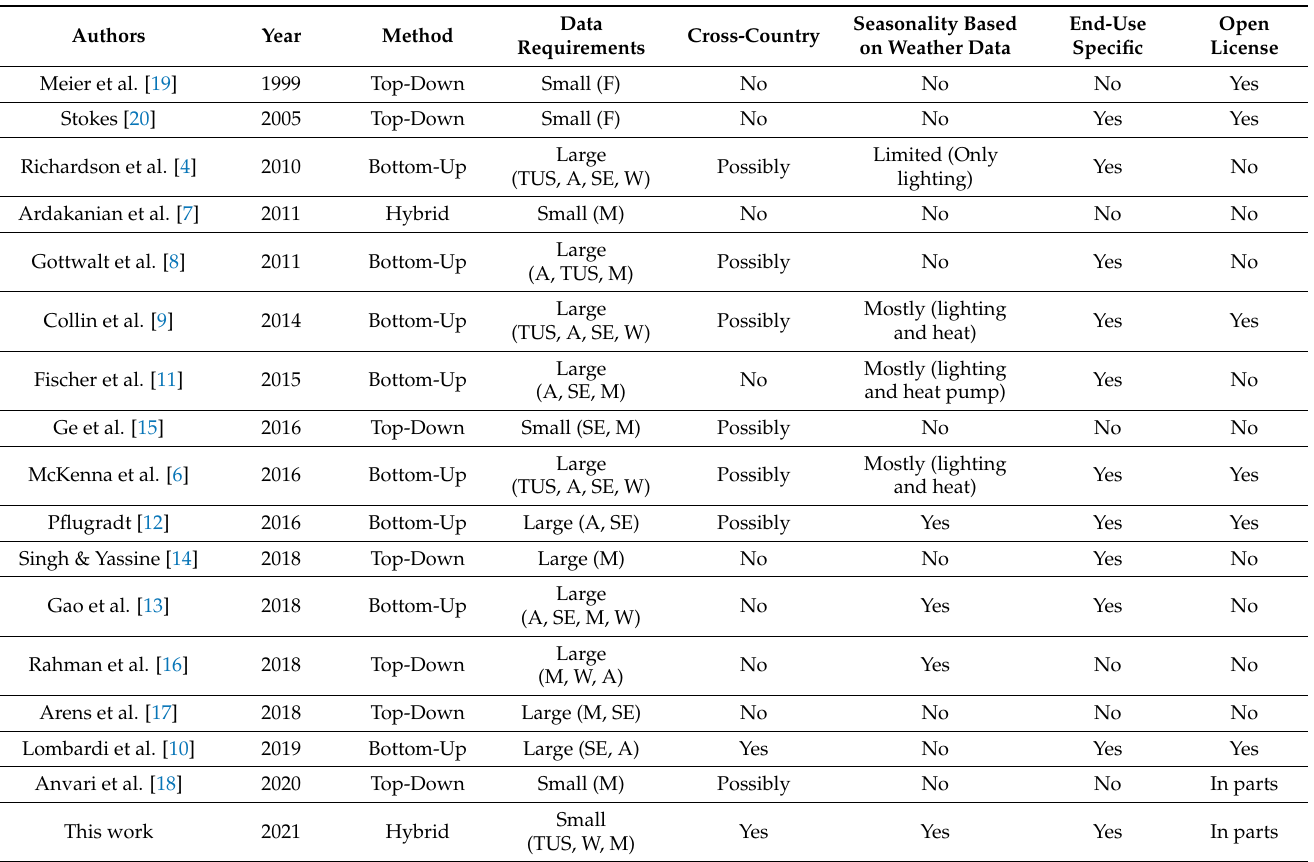
Table 1. Literature overview of related models. The models are sorted by year. The table provides information about the criteria necessary for further use in energy system models: Is the model able to be applied in multiple countries? Does weather data influence the seasonality? Is it end-use specific? Are input or output data or the model itself available under an open license? How much data are required to model larger regions? We define six categories of data: Formulas with fixed coefficients (F), time-use surveys (TUSs), appliance ownership (A), socio-economic data (SE), weather data (W), and load profile measurements (M). Please note that the amount of data categories alone does not define the total input data requirements, because the complexity between categories